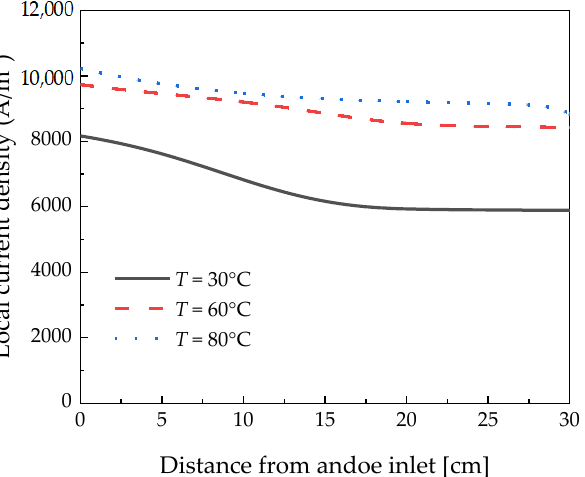
Figure 7. Local current density measured along the channel length according to the temperature at 0.18 V.